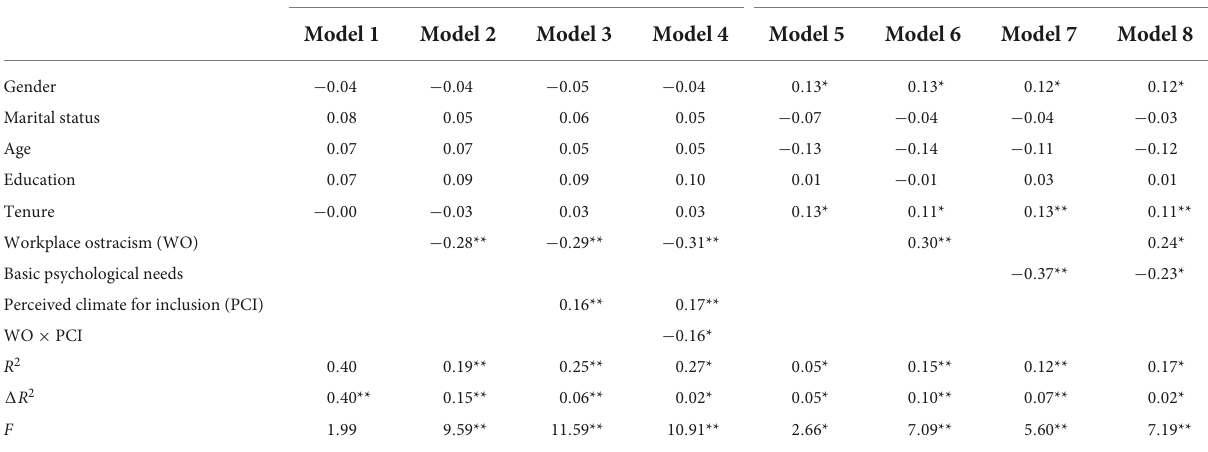
TABLE 4 Regression